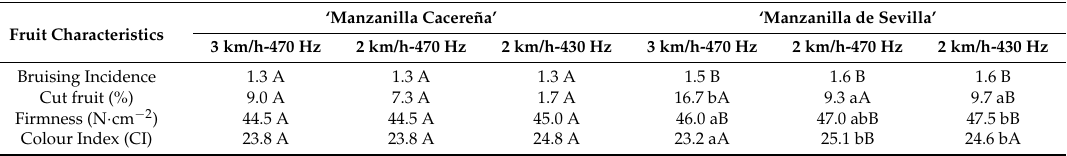
Table 4. Fruit damage for each nominal travel speed and beating